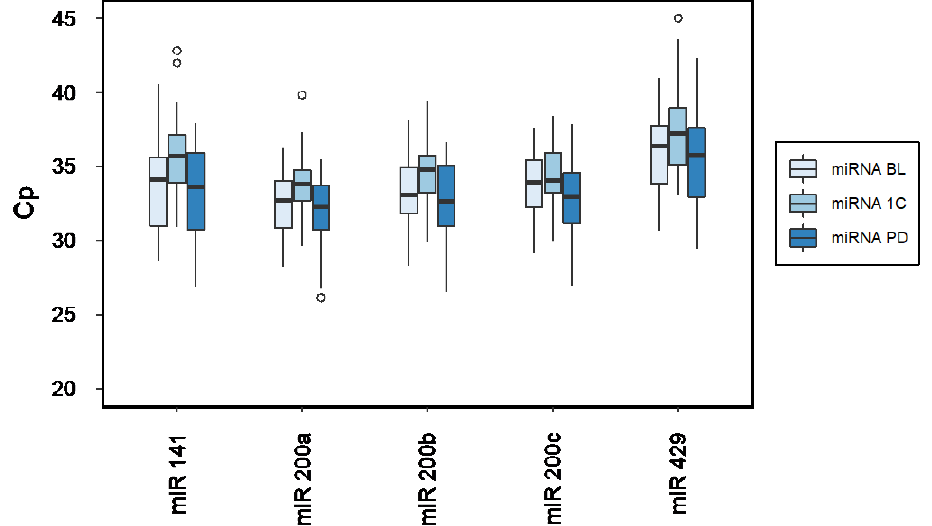
Figure 1. Comparison of miR-200s expression levels at baseline (miRNA BL ), after 1 completed cycle of a new line of systemic therapy (miRNA 1C ), and at the progression of disease (miRNA PD ) (outliers are shown as circles).